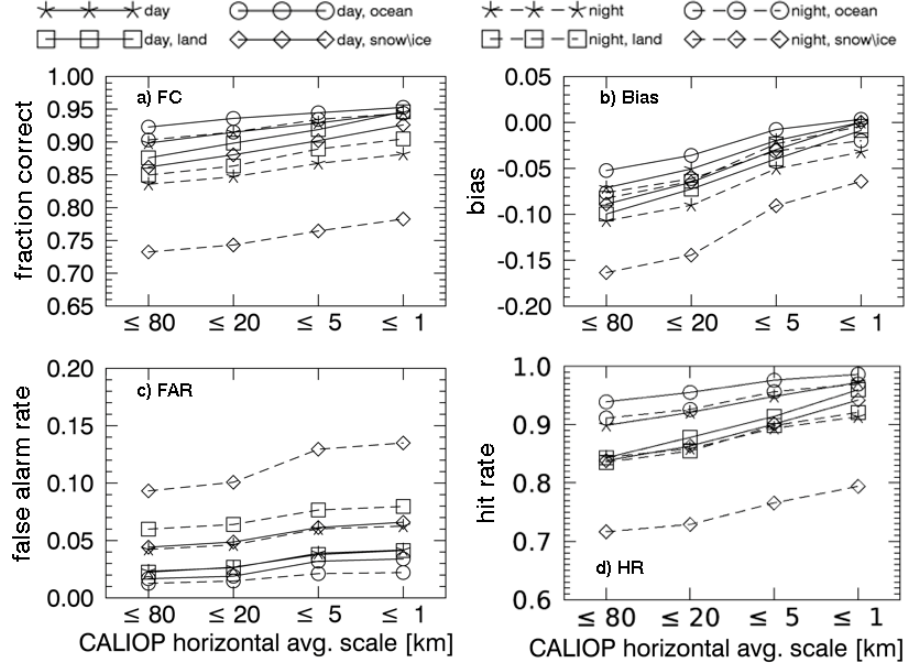
Figure 3. Dependence of CV1S cloud detection ( a ) fraction correct, ( b ) bias, ( c ) false alarm rate, and ( d ) hit rate on CALIOP horizontal averaging, JAJO, 2015–2016, for 0/100 matched pixels.